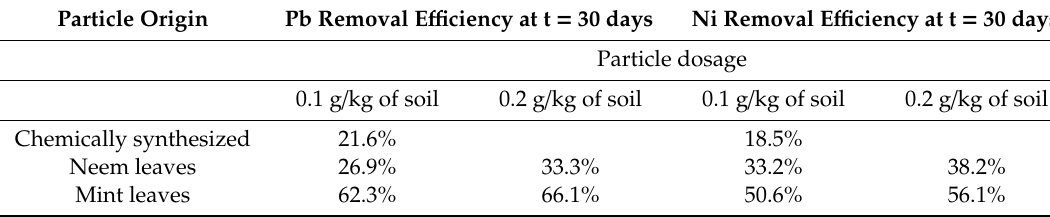
Table 2. The heavy metal removal e ffi ciency of the tested nZVI